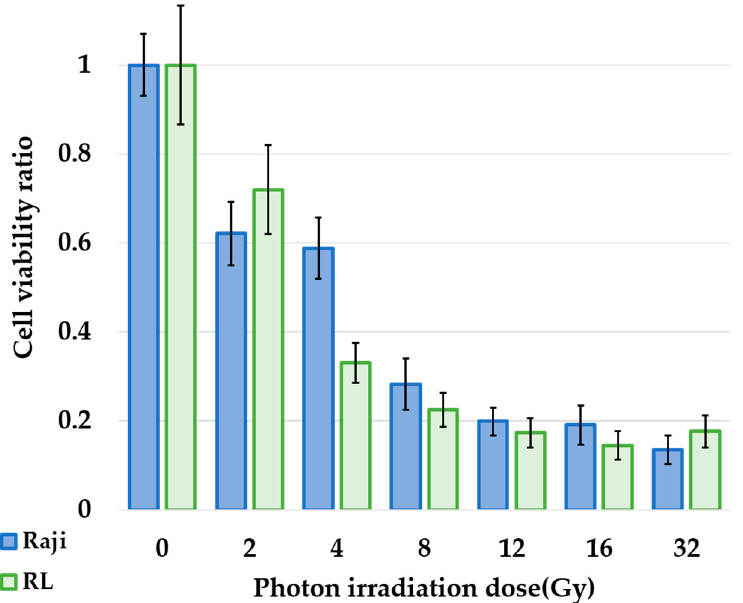
Figure 2. Relationship between cell viability ratio and photon radiation dose. The cell viability ratio of lymphoma cells after 96 h of irradiation from 0 to 32 Gy. Cell viability ratio of Raji cells are shown in blue, and that of RL are shown in green. There was a significantly decreased cell viability ratio by more than 2 Gy irradiation compared to 0 Gy in Raji and RL ( p < 0.05).